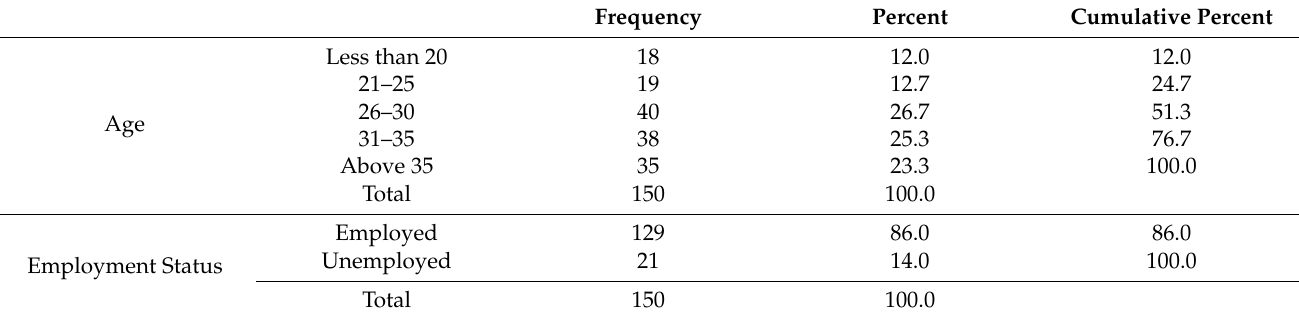
Table 1. Demographic Profile of the Survey Respondents.